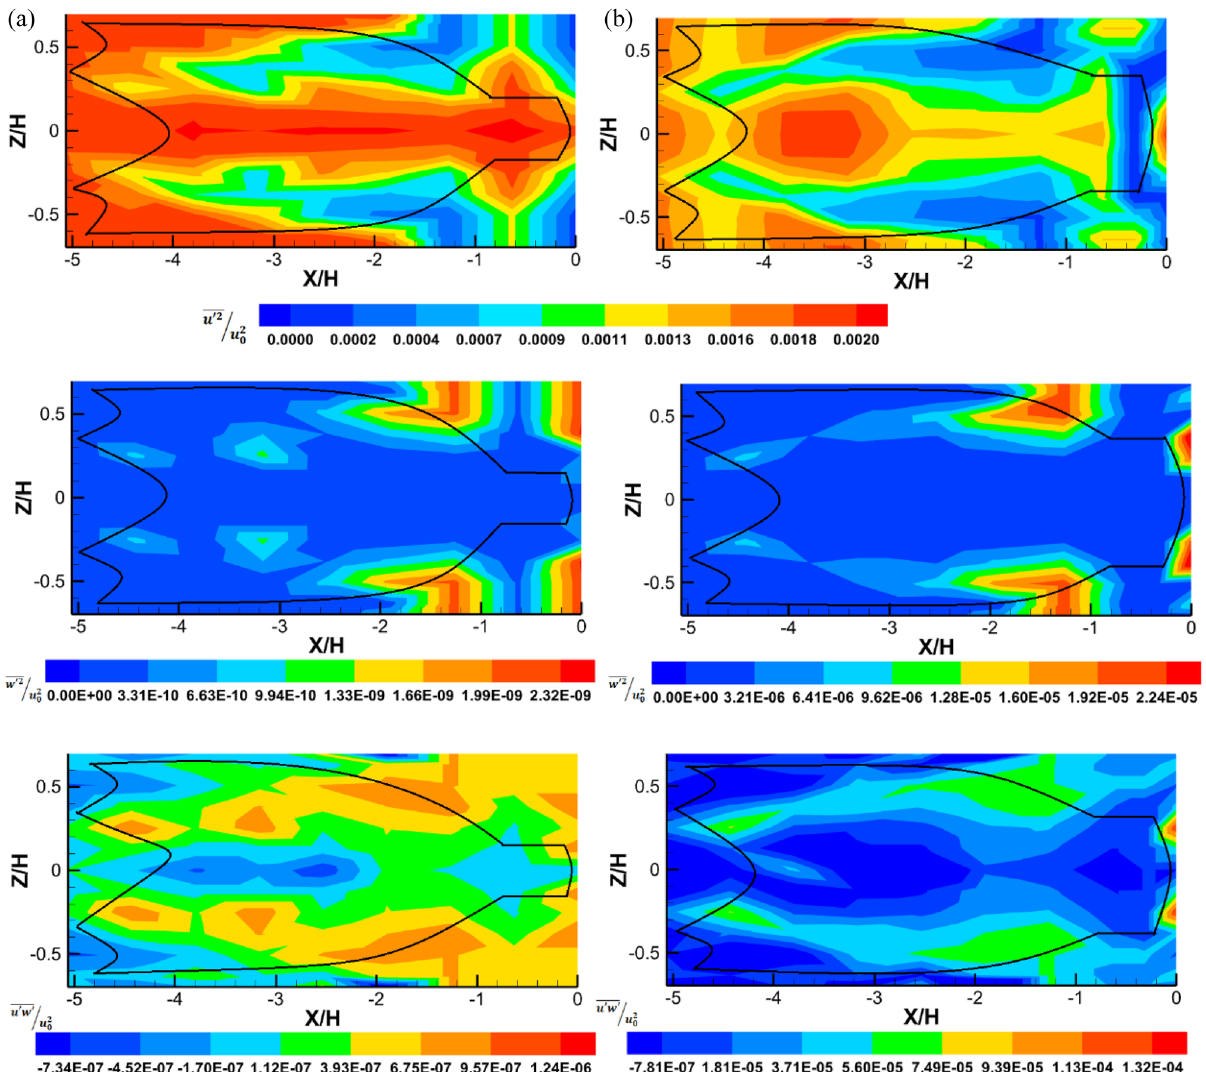
Figure 7. Reynolds stresses tensor components of the flow field inside and around ( a ) trawl net without catch 2 w ′ 2 / u 2 u ′ w ′ / u 2 and ( b ) trawl net without catch: (up) ( u ′ 2 / u 0 ), (middle) 0 , and (bottom) 0 peaks for the trawls without catch and with catch were at low frequencies of f 1 = 0.066 and 0.033 Hz, respectively (Fig. 8c). On the transverse structure’s oscillations, the second frequency peaks were at f 2 = 0.53 and 0.50 Hz for the trawls without catch and with catch, respectively (Fig. 8). In this case, the interaction between f 1 and f 2 induces an additional frequency f 3 = f 2 − f 1 = 1.067 and 0.80 Hz for the trawls without catch and with catch, respectively, on x -oscillations. On z -oscillations, f 3 was 0.370 and 0.467 Hz for the trawls without catch and with catch, respectively. The spectra obtained in the trawl with catch exhibited a dominant low-frequency component compared to that of the trawl without catch. When regarding the power spectrum content, the amplitude of the transverse oscillation’s spectra was 29.65% and 74.11% higher than that of streamwise oscillation spectra for the trawls without catch and with catch, respectively (Fig. 9c,d). Analysis of the higher-order moments. Analysis of the turbulent flux and gradient of turbulent kinetic energy flux. Figure 9a,b shows the turbulent flux ( D u ) inside and around the midwater trawl both without catch and with catch. For the trawl without catch, the distribution of D u are uniformly higher with negative values varying from – 3.6× 10 − 11 to − 6.06× 10 − 16 , the lower distributed values of − 5.6× 10 − 11 to − 3.6× 10 − 11 obtained inside and around the end-part of the codend are exempted due to the free motions on the X/H–Z/H axis. For the trawl with catch, D u distribution varies consistently, with the lower values varying from − 4.18× 10 − 3 to 1.13× 10 − 7 except the values varying from 1.52× 10 − 7 to 2.31 × 10 − 7 , inside the trawl wing at − 5.06 < X/H < − 4.43 (Fig. 9b). The magnitude value of D u was higher inside and around the trawl net with catch compared to that in- side and around the trawl without catch (Fig. 9). This means that the diffuse transport of the Reynolds stress, the energy dissipation, and the gradient turbulent stress developing inside and around the trawl net were strongly affected by the disturbance of the flow passage through the trawl.